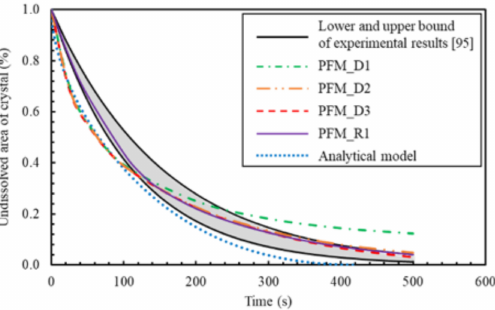
Figure 12. Comparison of numerical and experimental results of NaCl single particle